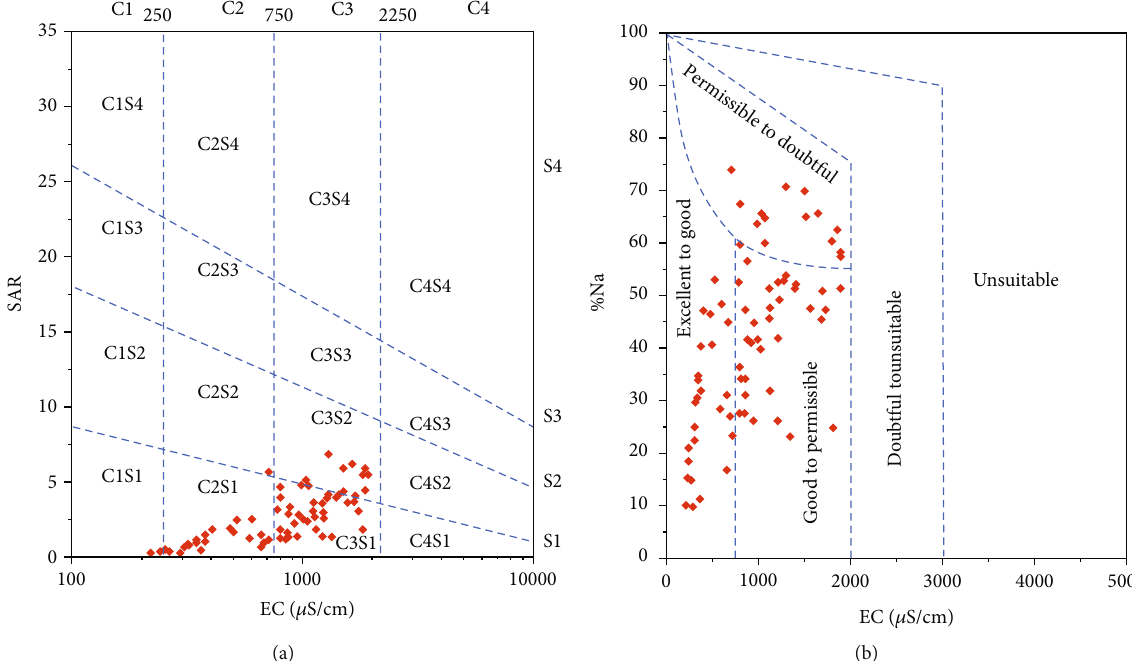
Figure 7: (a) USSL diagram for irrigation water classi fi cation. (b) Plot of percentage sodium (%Na) versus EC.